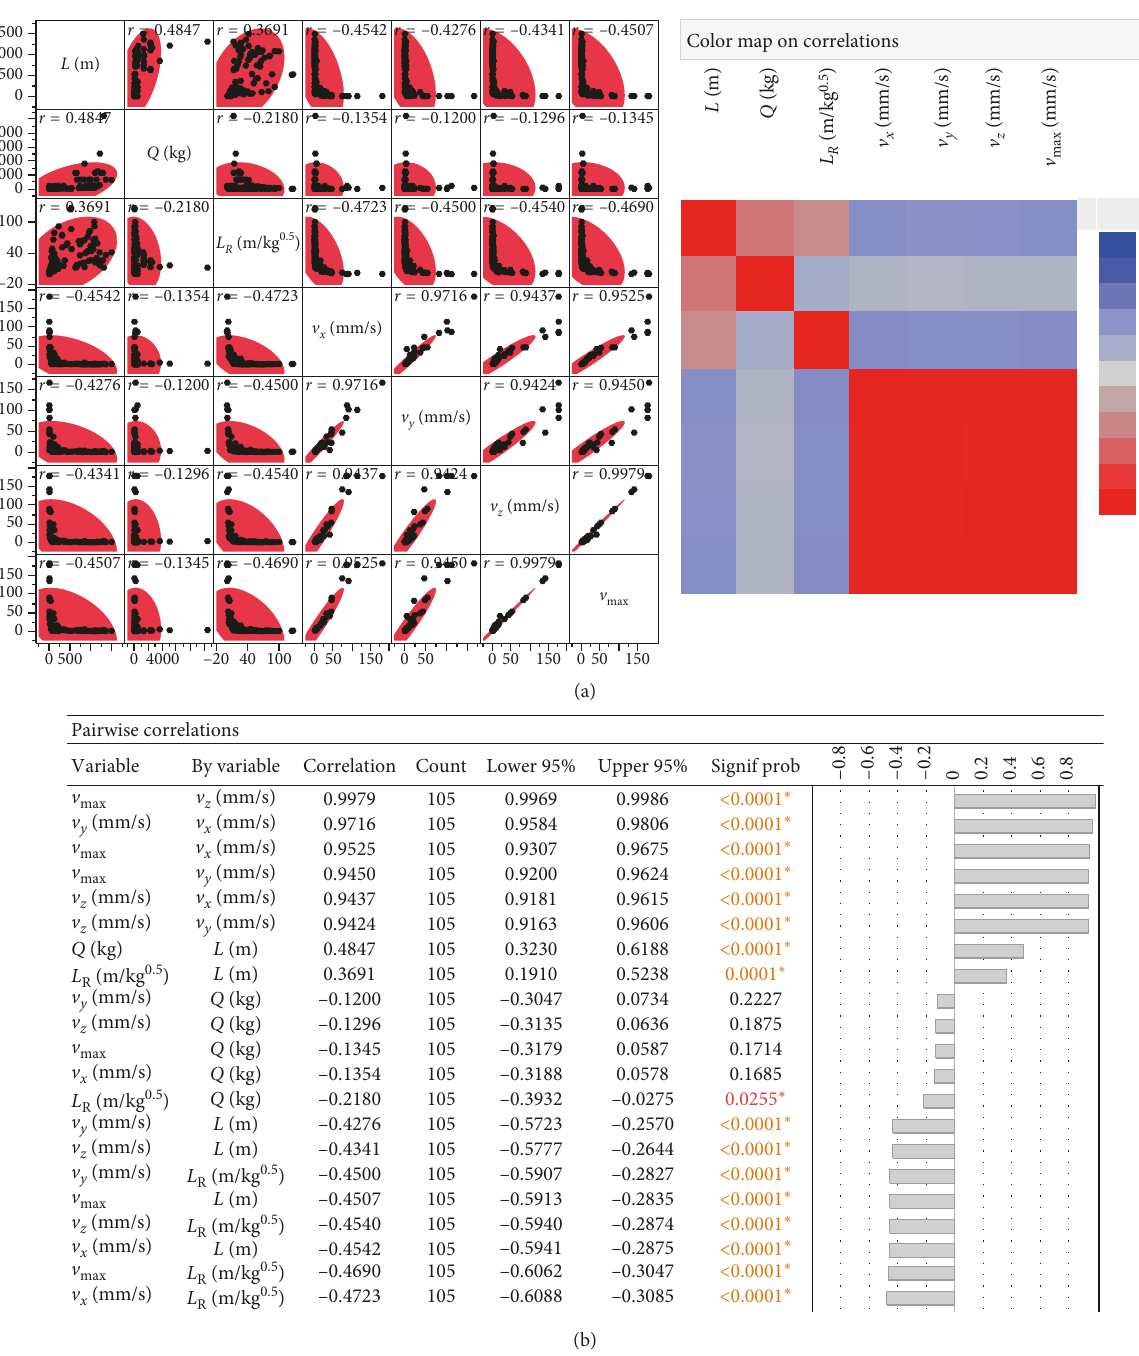
Figure 1: Multivariate analysis of numerical data. (a) Scatterplot matrix. (b) Pairwise